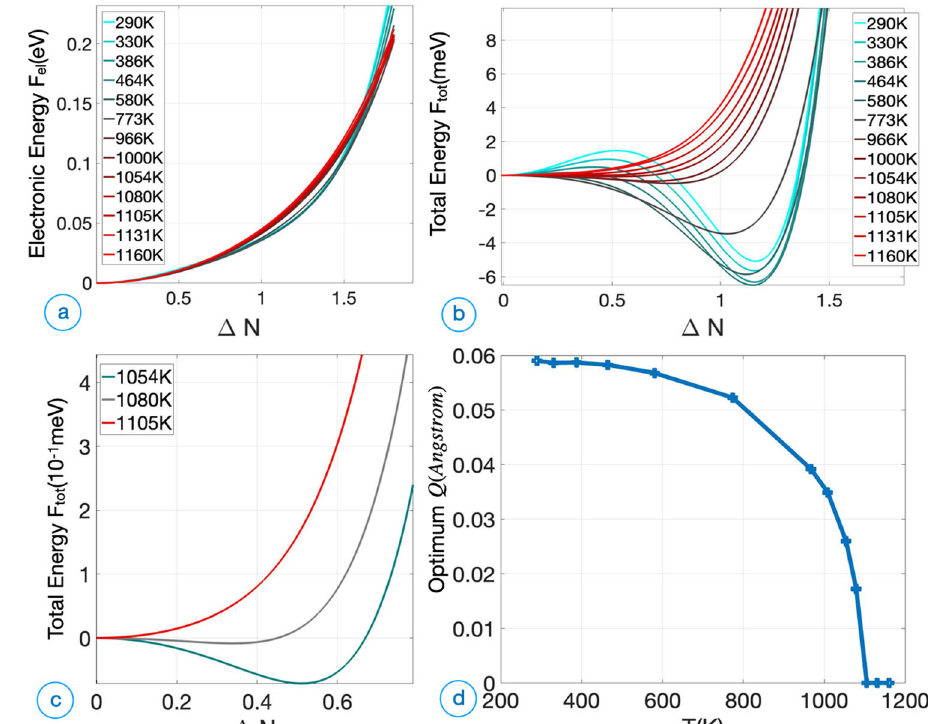
Fig. 10 Evolution of the electronic and total energy landscape of NdNiO 3 as a function of electronic temperature. a Electronic free energy as function of electronic disproportionation Δ N computed for NdNiO 3 at temperatures from 290 to 1160 K. b Total free energy computed for bulk NdNiO 3 for the same temperature range. c Total expanded view of total free energy for bulk NdNiO 3 at temperatures close to the transition. d Optimal bond disproportionation Q , as obtained by a linear transformation from the electronic disproportionation Δ N , using the lattice stiffness K and electron-lattice coupling term g : Q ( T ) = Δ N ð T Þ g . Data for fi ts provided in Supplementary Note 2 K